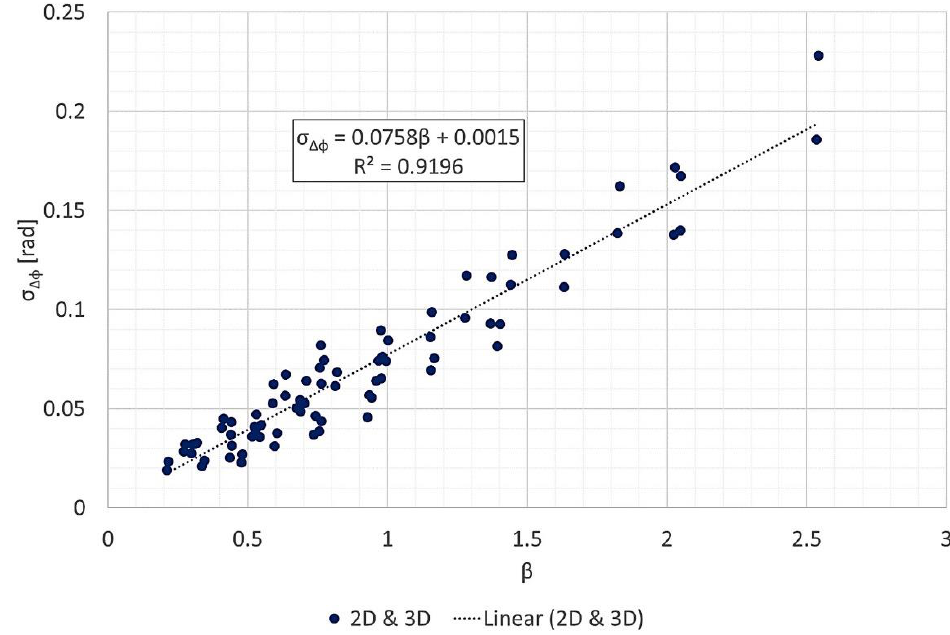
Figure 16. Phase error standard deviation σ ∆ φ vs. β , with the same linear regression for both 2D and 3D data. The statistics for all three linear regression models are indicated in Table 4.